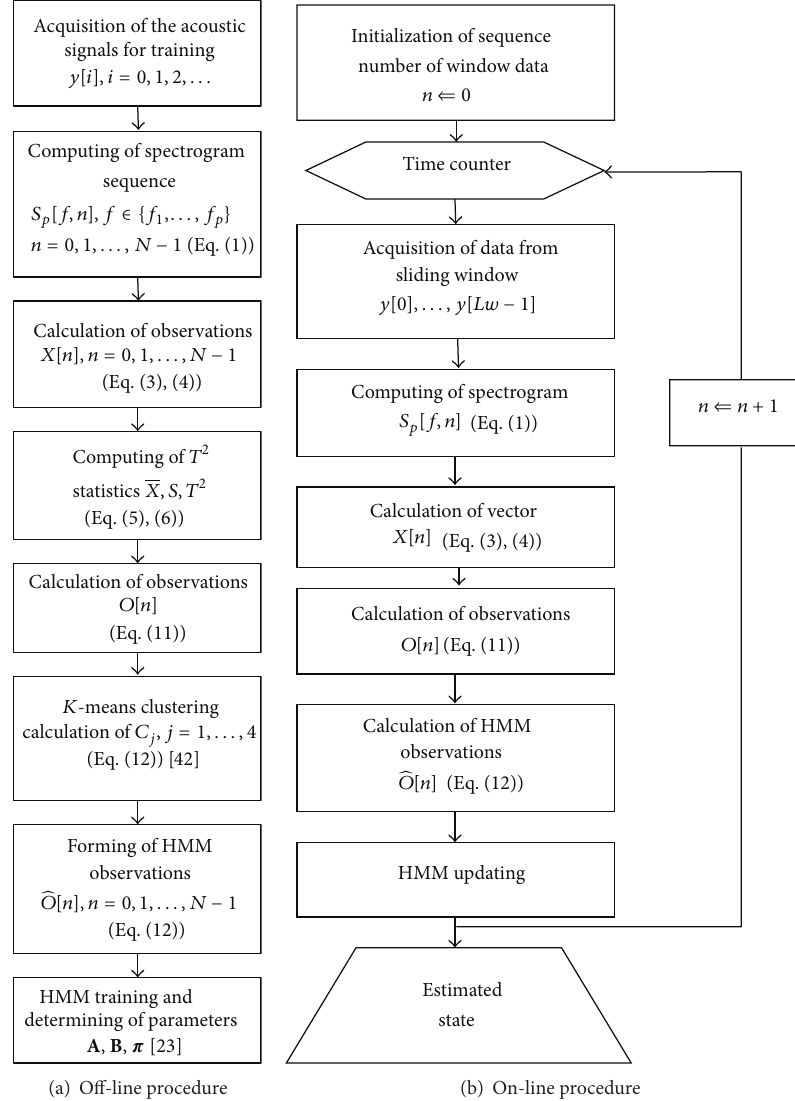
Figure 4: Flow diagram of the proposed